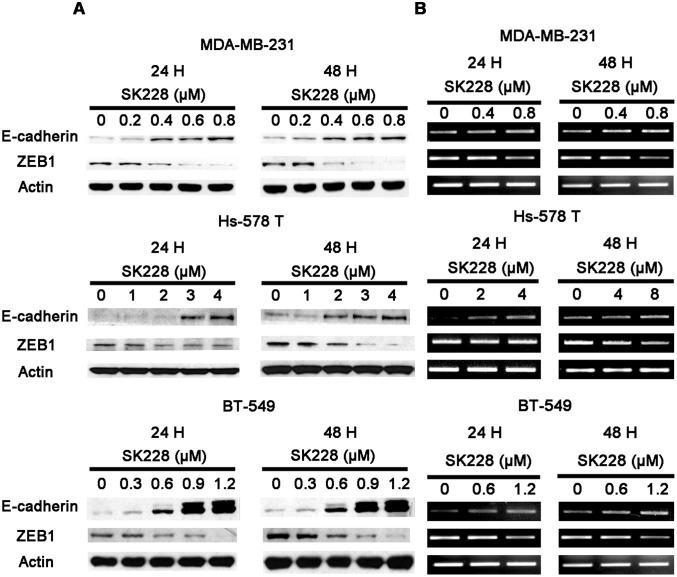
SK228 increases the expression of E-cadherin and decreases the expression of ZEB1 in breast cancer cells.SK228 increases the expression of E-cadherin and decreases the expression of ZEB1 as assessed by using Western Blot analysis (A) and RT-PCR (B).